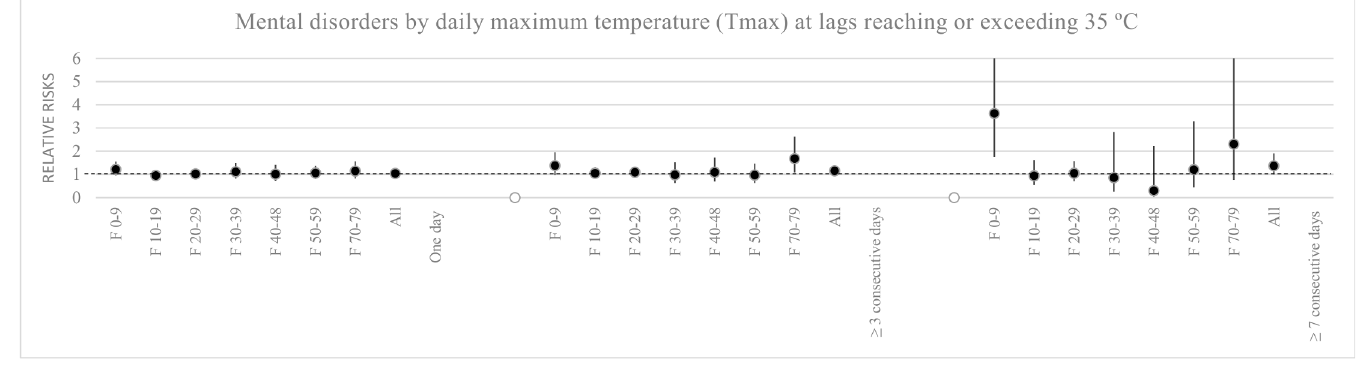
Fig 4. Mental disorders by daily maximum temperature at lags reaching or exceeding 35°C. The number of cases for mental disorders increased with the length of the heatwave with relative risk estimating to 1.04 (0.95 – 1.13), 1.15 (1.005 – 1.31) and 1.36 (1 – 1.90) for one day, at least three days, or seven days in a row.